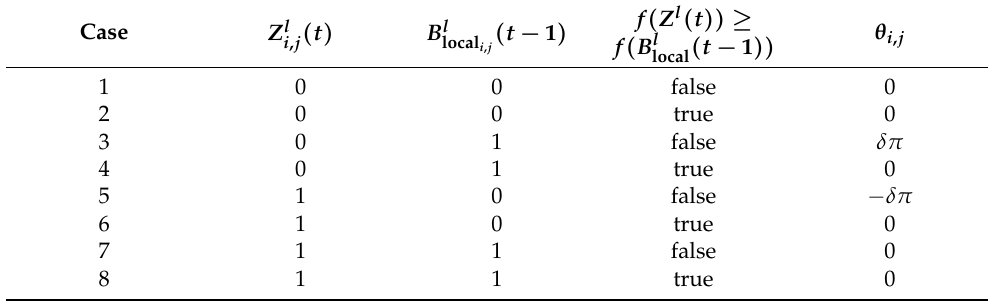
Table 1. Evaluation cases to define rotation angle.